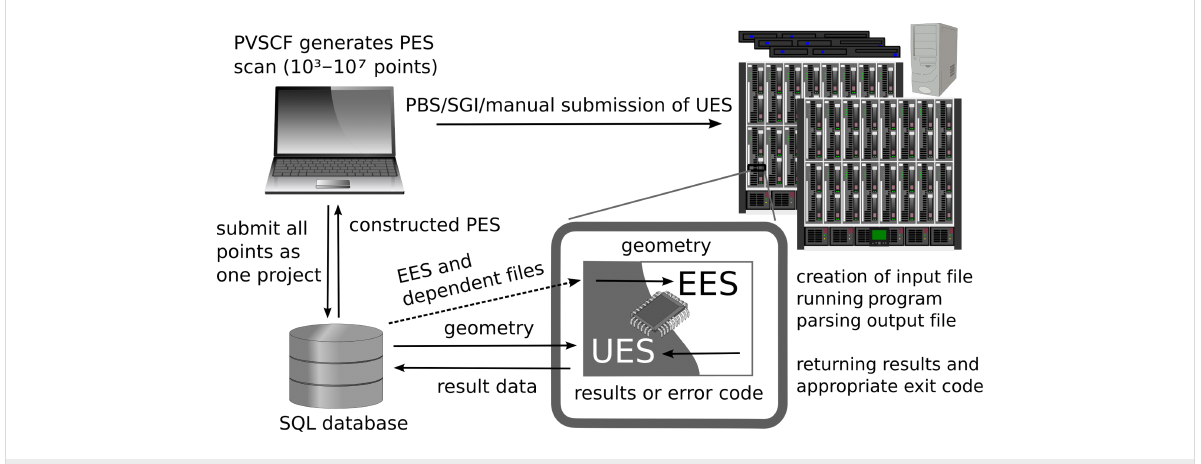
Figure 8: Diagrammatic representation of the grid